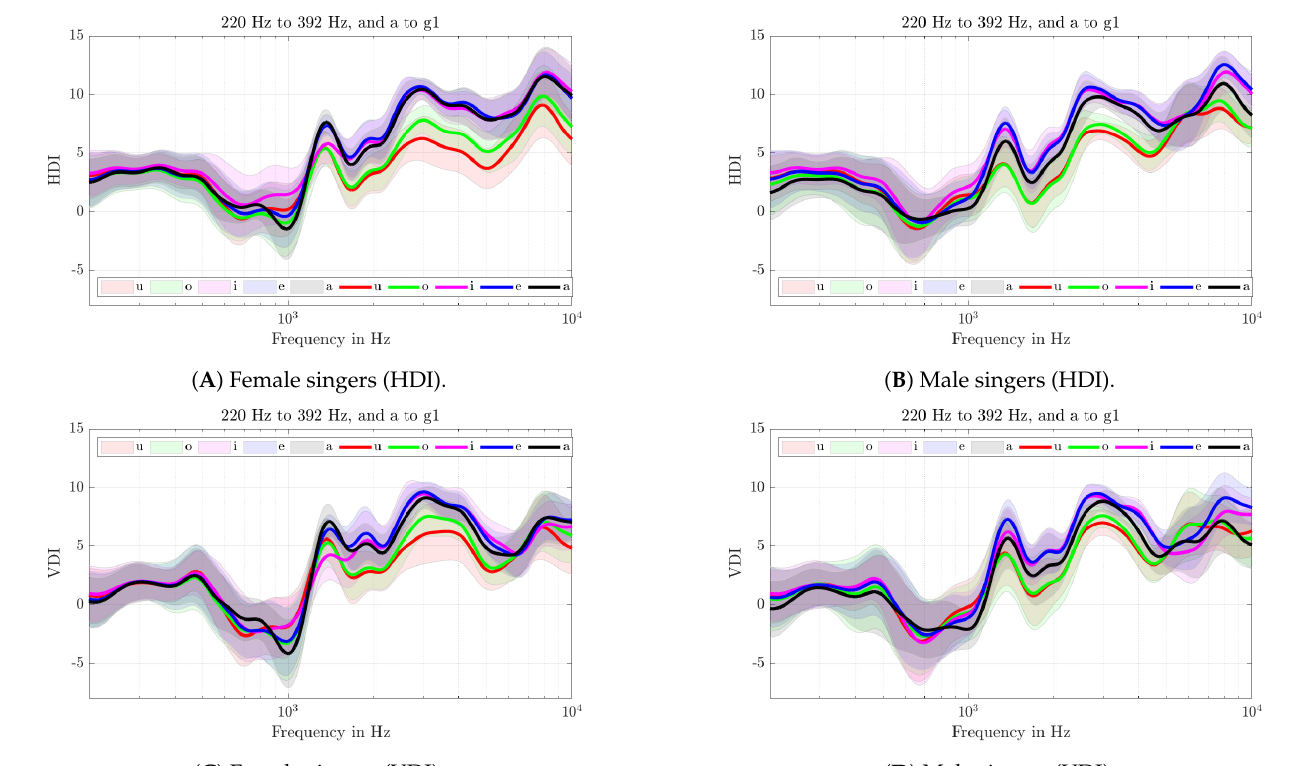
Figure 3. Mean and standard deviation for the horizontal and vertical directivity index in dB averaged over pitch (a/A3/220 Hz to g1/G4/392 Hz) for the female singers ( A , C ) and male singers ( B , D ) for all five vowels and all phonation